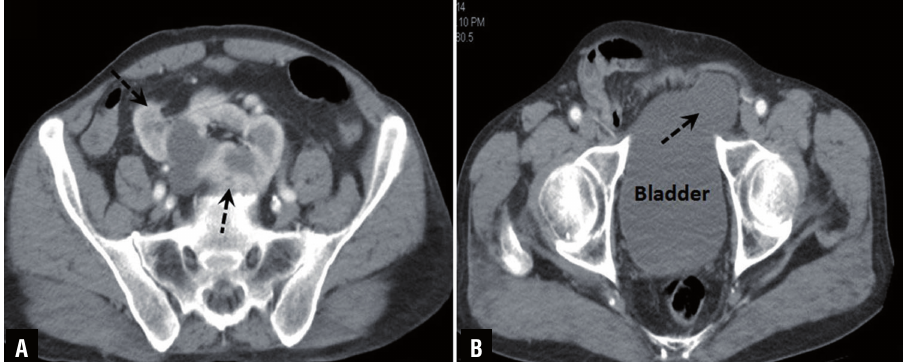
figure 1 - Axial CT images show pancake kidney and bladder herniation (dashed